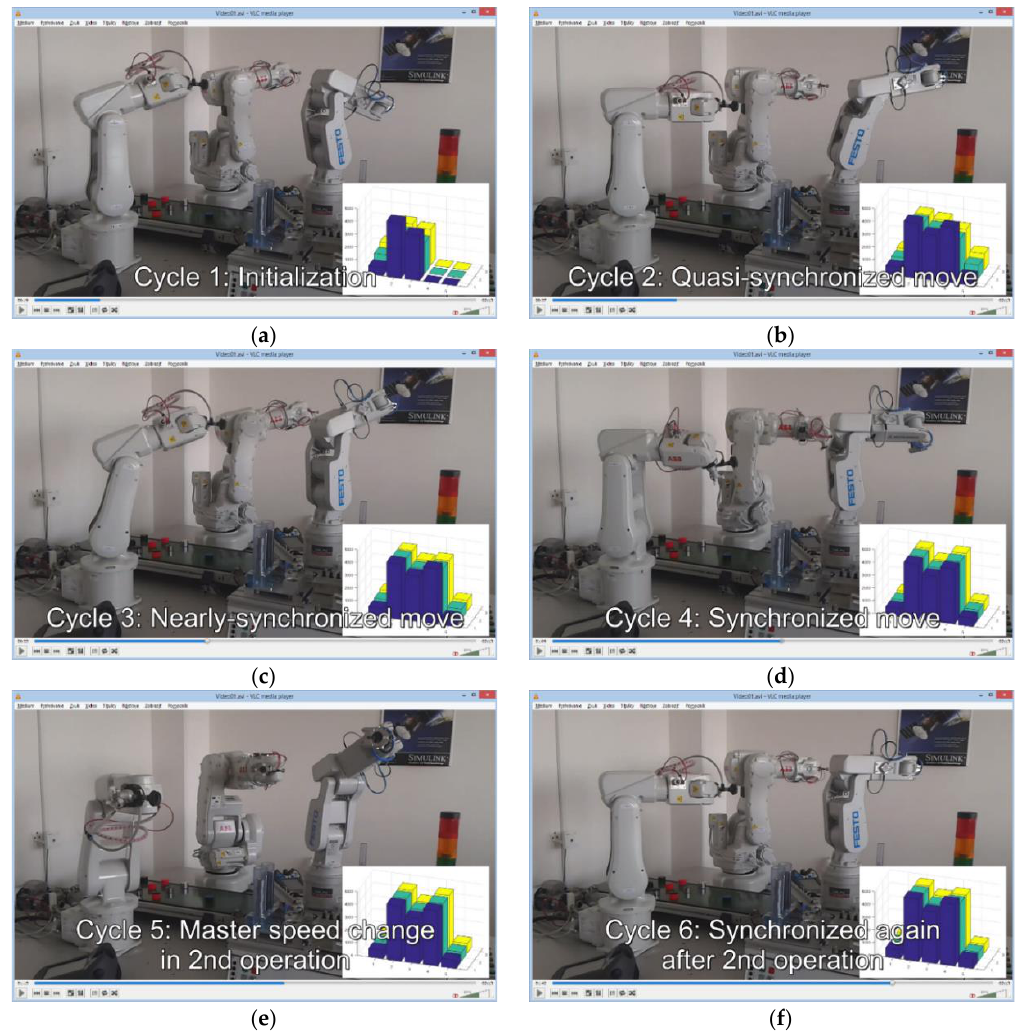
Figure 19. Implementation and visualization – synchronization without feedforward effect. ( a ) Initial cycle; ( b ) Quasi-synchronized state; ( c ) Nearly-synchronized state; ( d ) Synchronized state; ( e ) Master speed change cycle; ( f ) Resynchronized state.